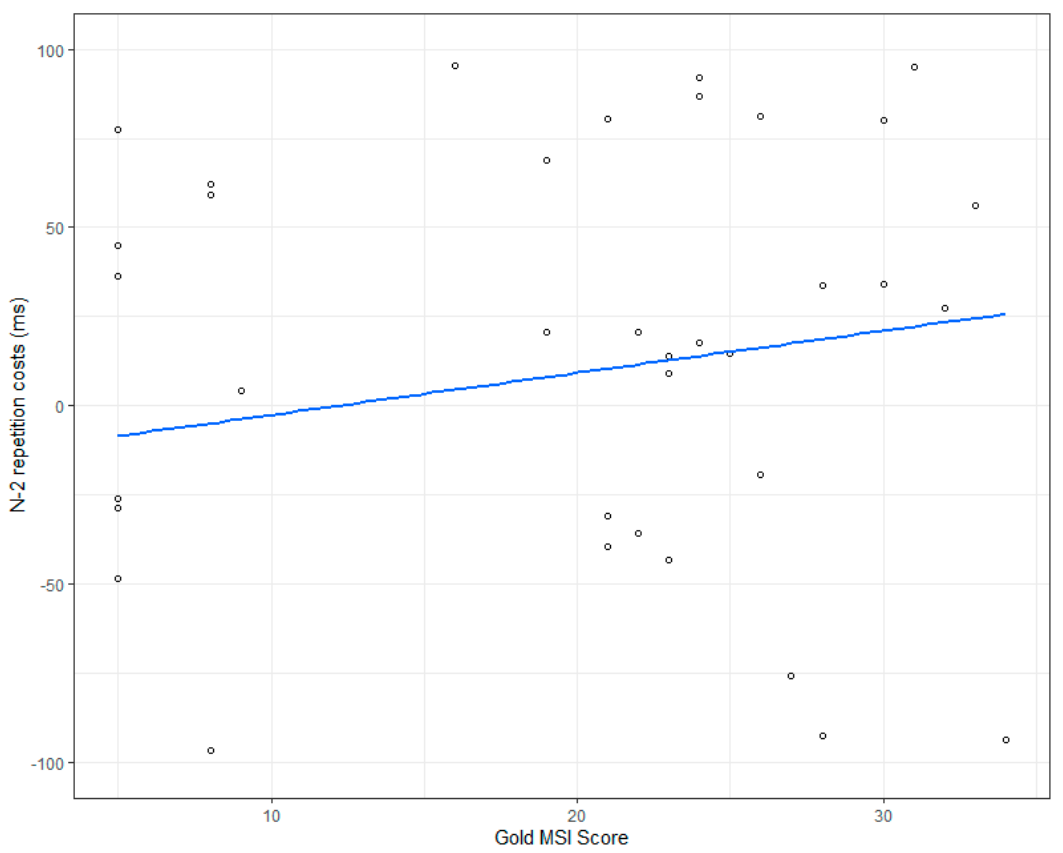
10 of 15 Table 4. Estimates for mixed model on n-2 repetition costs (dependent variable: reaction times). Factor